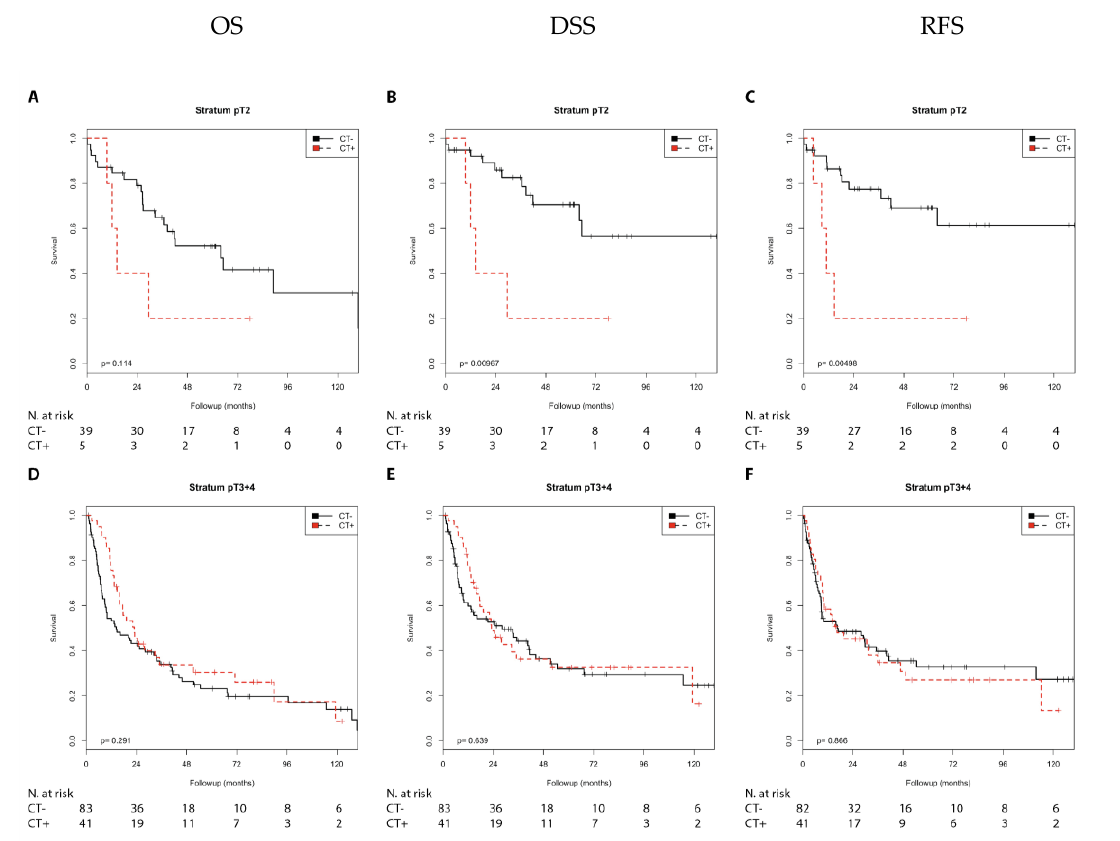
Figure 2. Kaplan–Meier analysis: Association of chemotherapy with prognosis (OS, DSS, and RFS) stratified by tumor stage (pT2 or pT3 + 4). In the pT2 group ( A – C ), chemotherapy was not associated with OS ( A ) but was associated with DSS ( B ; p = 0.010) and RFS ( C ; p = 0.005). In the pT3 + 4 group ( D – F ), chemotherapy was not associated with OS ( D ), DSS ( E ), or RFS ( F ). Table 1. Univariate Cox’s regression analysis: Association between chemotherapy and prognosis stratified by the nodal stage and/or tumor stage.